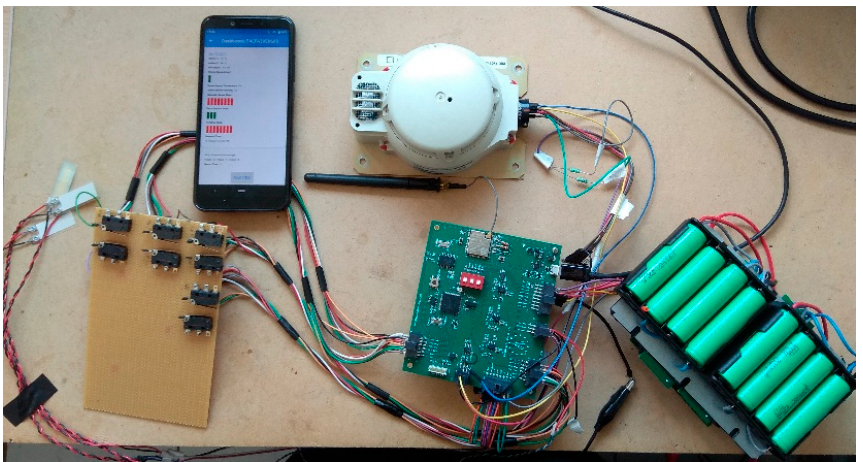
Figure 14. “INTELLICONT” full system.